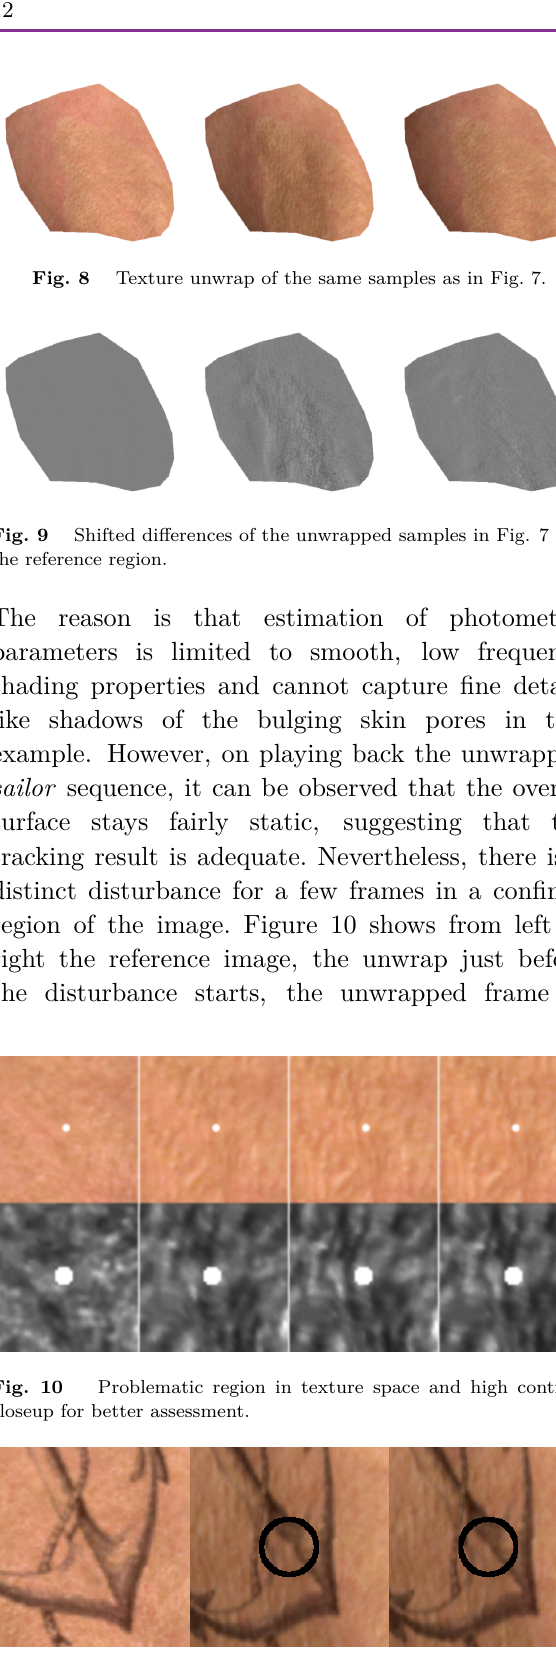
Fig. 11 Closeup of a problematic tracking region in the final